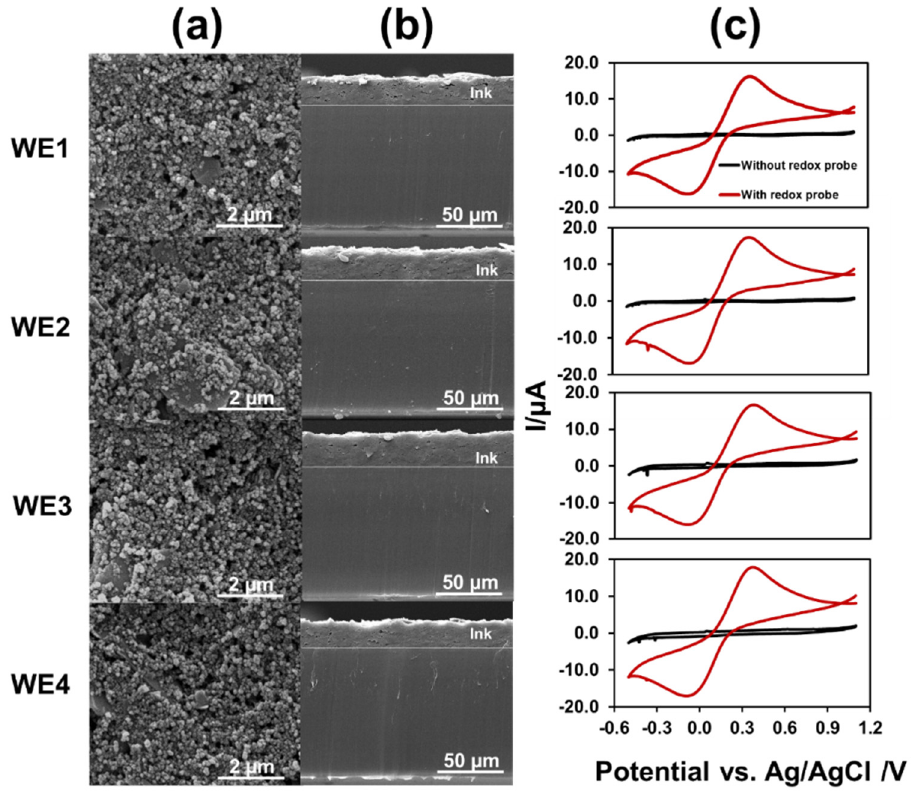
Figure 4. Surface morphologies ( a ) and cross-sections ( b ) of 4WEs were studied using scanning electron microscopy. The cyclic voltammograms of the MGrEs in 0.1 M KCl without (black line) and with 1.0 mM Fe(CN 6 ) 3 − /4 − (red line) ( c ).